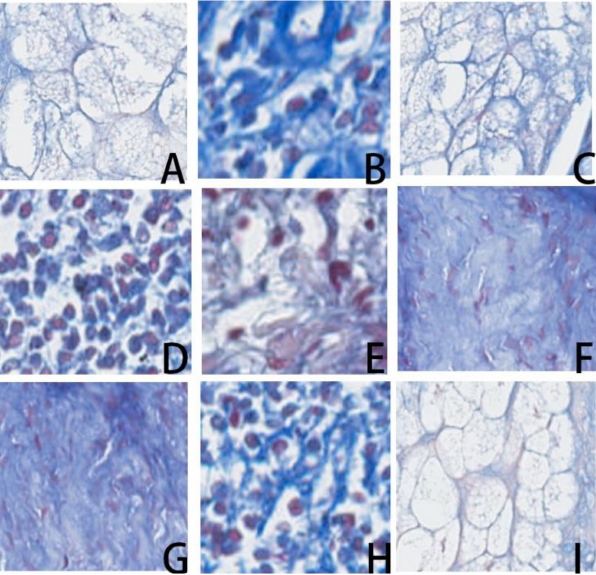
Figure 3. From left to right and top to bottom to have A – I images, they are contamination (images A , F ), hair follicle and hair shaft (images B , H ), corneal layer of epidermis (images C , D ), amorphous background staining (images E , G , and I ) collected as negative samples in the faint group.